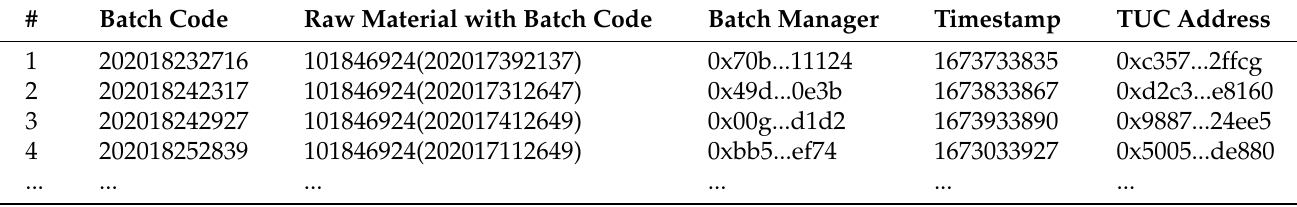
Table 5. Example of Batch Addition Contract (BAC) contract product code for the 7039501445899 in Table